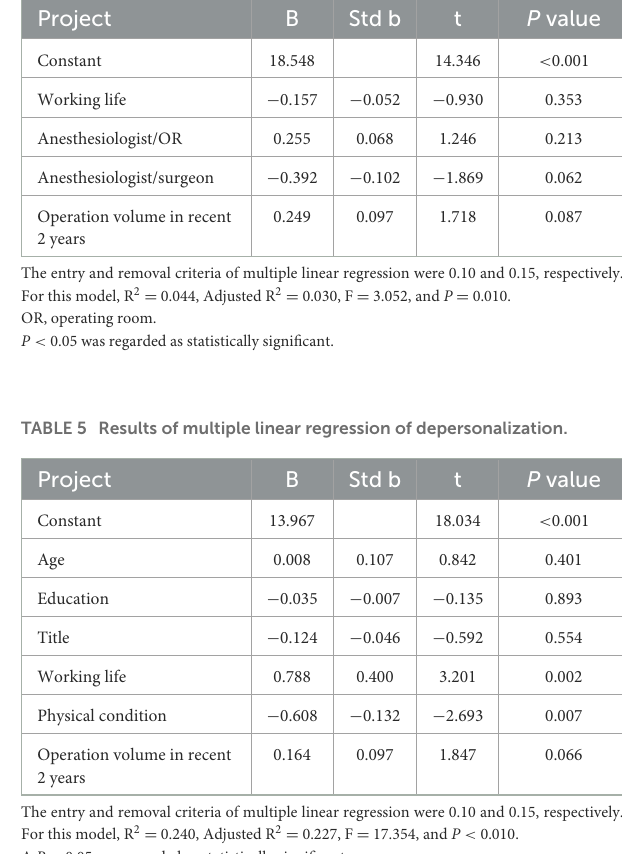
TABLE 7 Results of multiple linear regression of personal accomplishment job